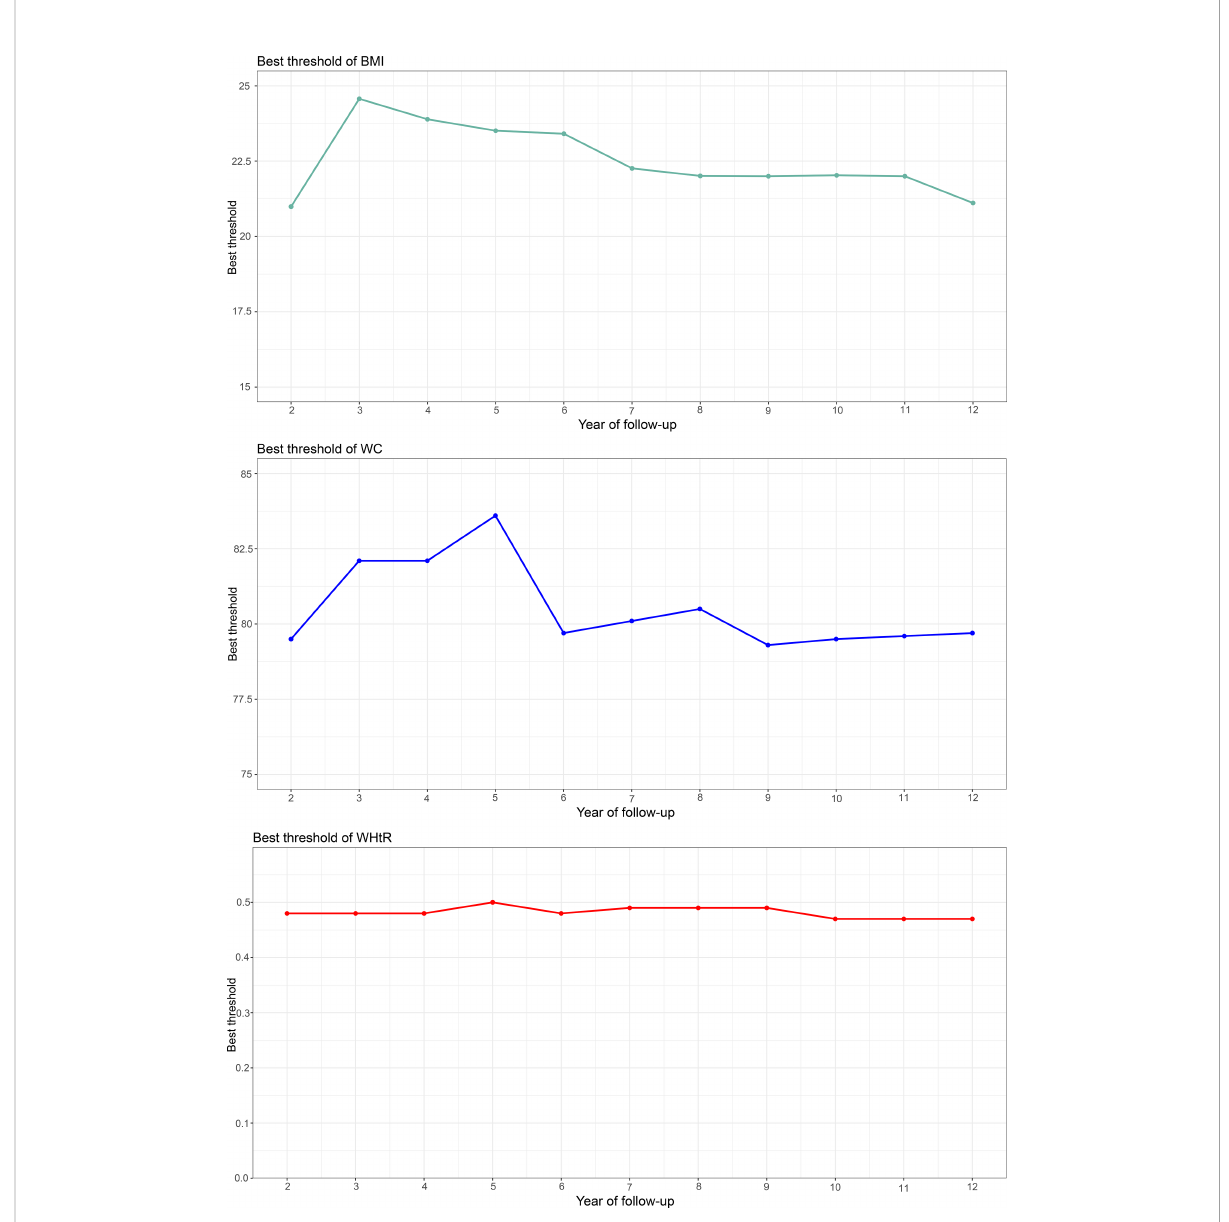
FIGURE 2 Threshold fl uctuation of BMI, WC and WHtR used to predict future diabetes risk. BMI, body mass index; WC, waist circumference; WHtR, waist- height